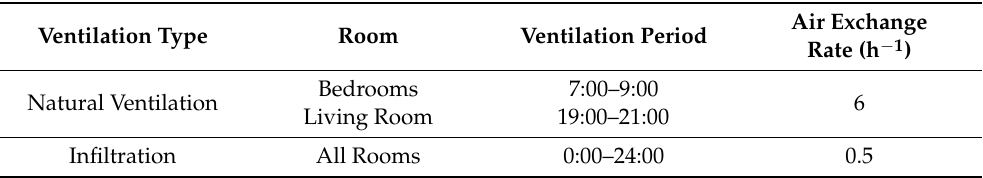
Table 6. Simulation parameters for ventilation.